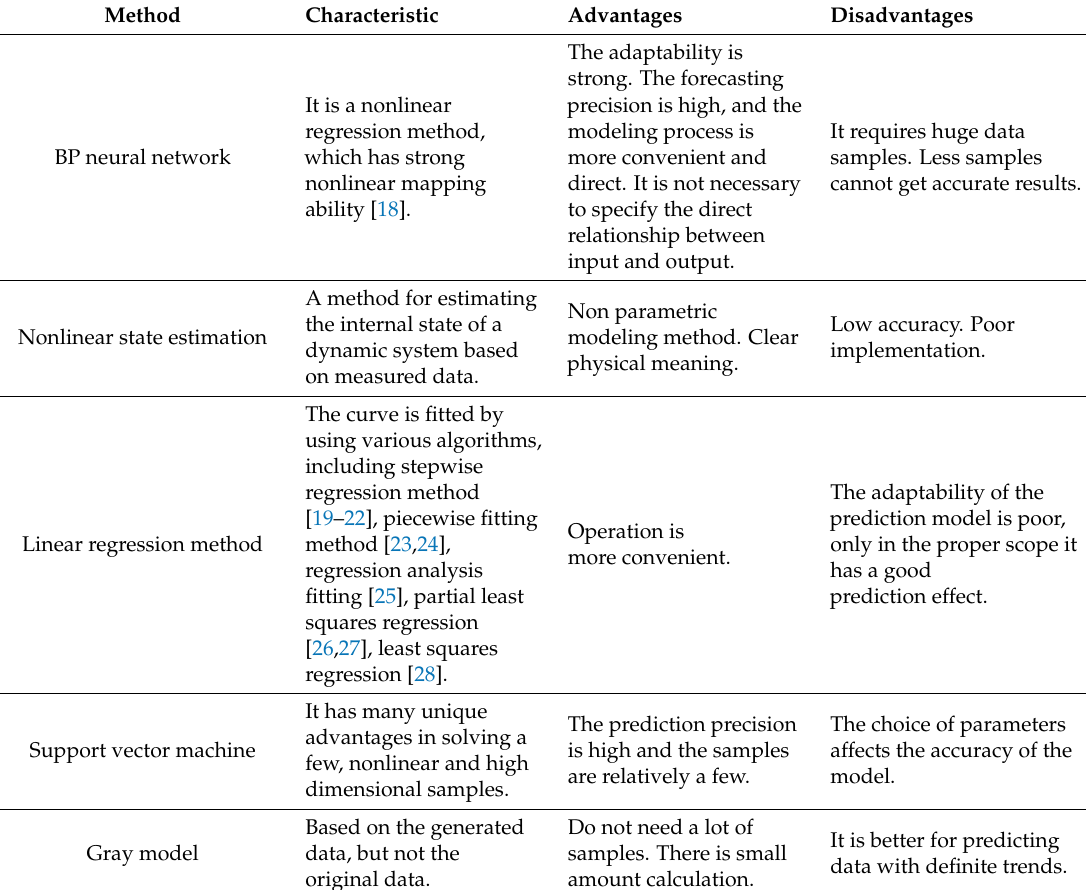
Table 1. Comparison of temperature prediction